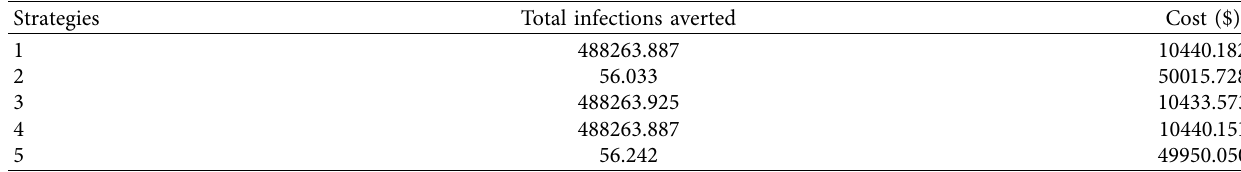
Table 2: Costs and health benefts of various intervention strategies.